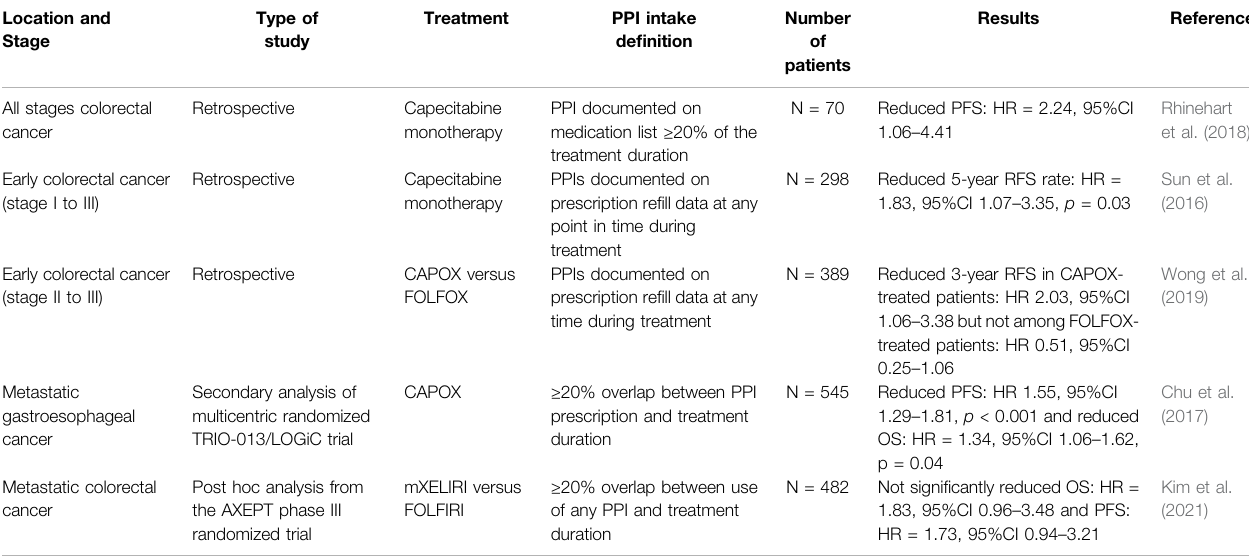
TABLE 2 | Main studies on interaction of capecitabine and co-medication with proton pump